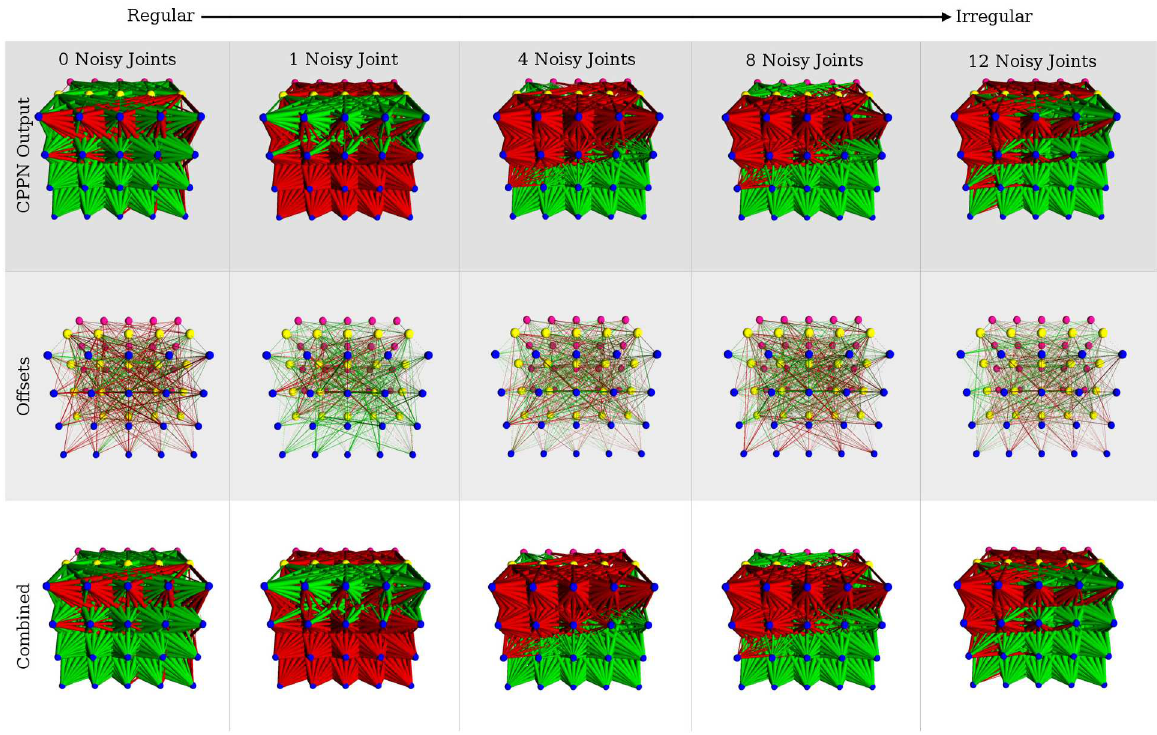
Fig 21. The fittest Offset-HybrID ANNs from each regularity of the quadruped robot experiment viewed from the output layer. Red links are inhibitory, green links are excitatory, and link weight magnitude is indicatedby the thickness of the link. A small and significantnegativecorrelationwas found betweenoffset magnitude and problem regularity(Spearmanrank correlation, ρ = − 0.293, p < 0.0001).